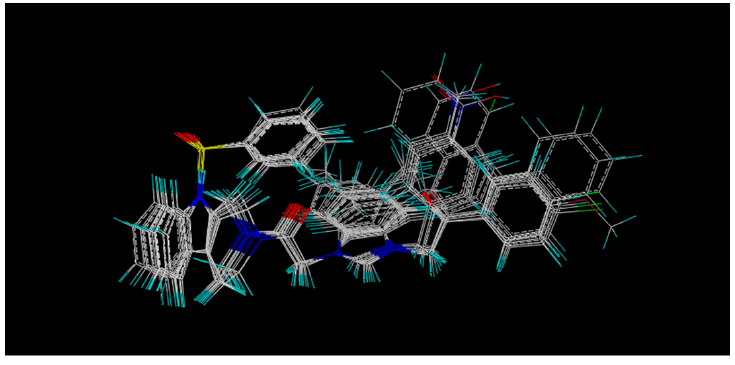
Figure 2. Superimposition of data set compounds for CoMSIA molecular field generation. Table 1. The PLS statistical parameters for the Topomer CoMFA and CoMSIA.